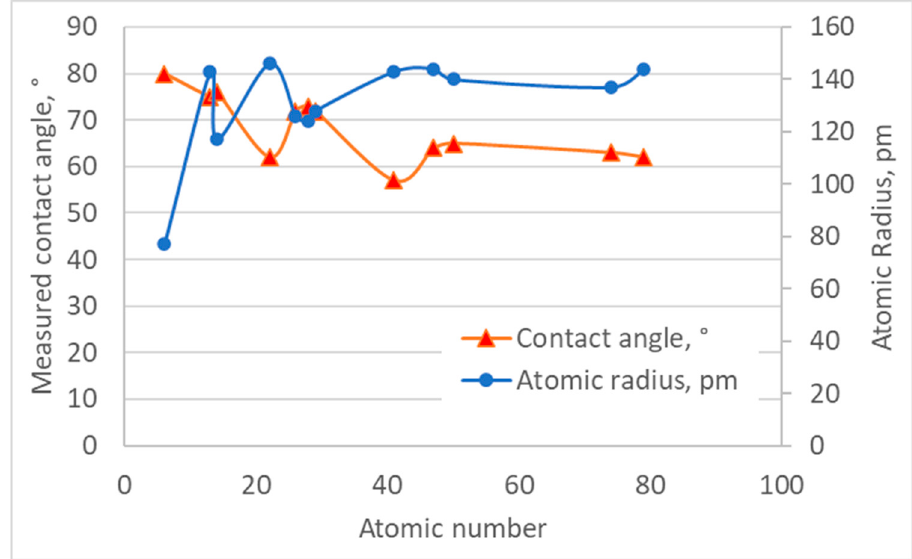
Figure 3. The measured contact angle of distilled water and radius of the substrate atoms as a function of the substrate atomic number.